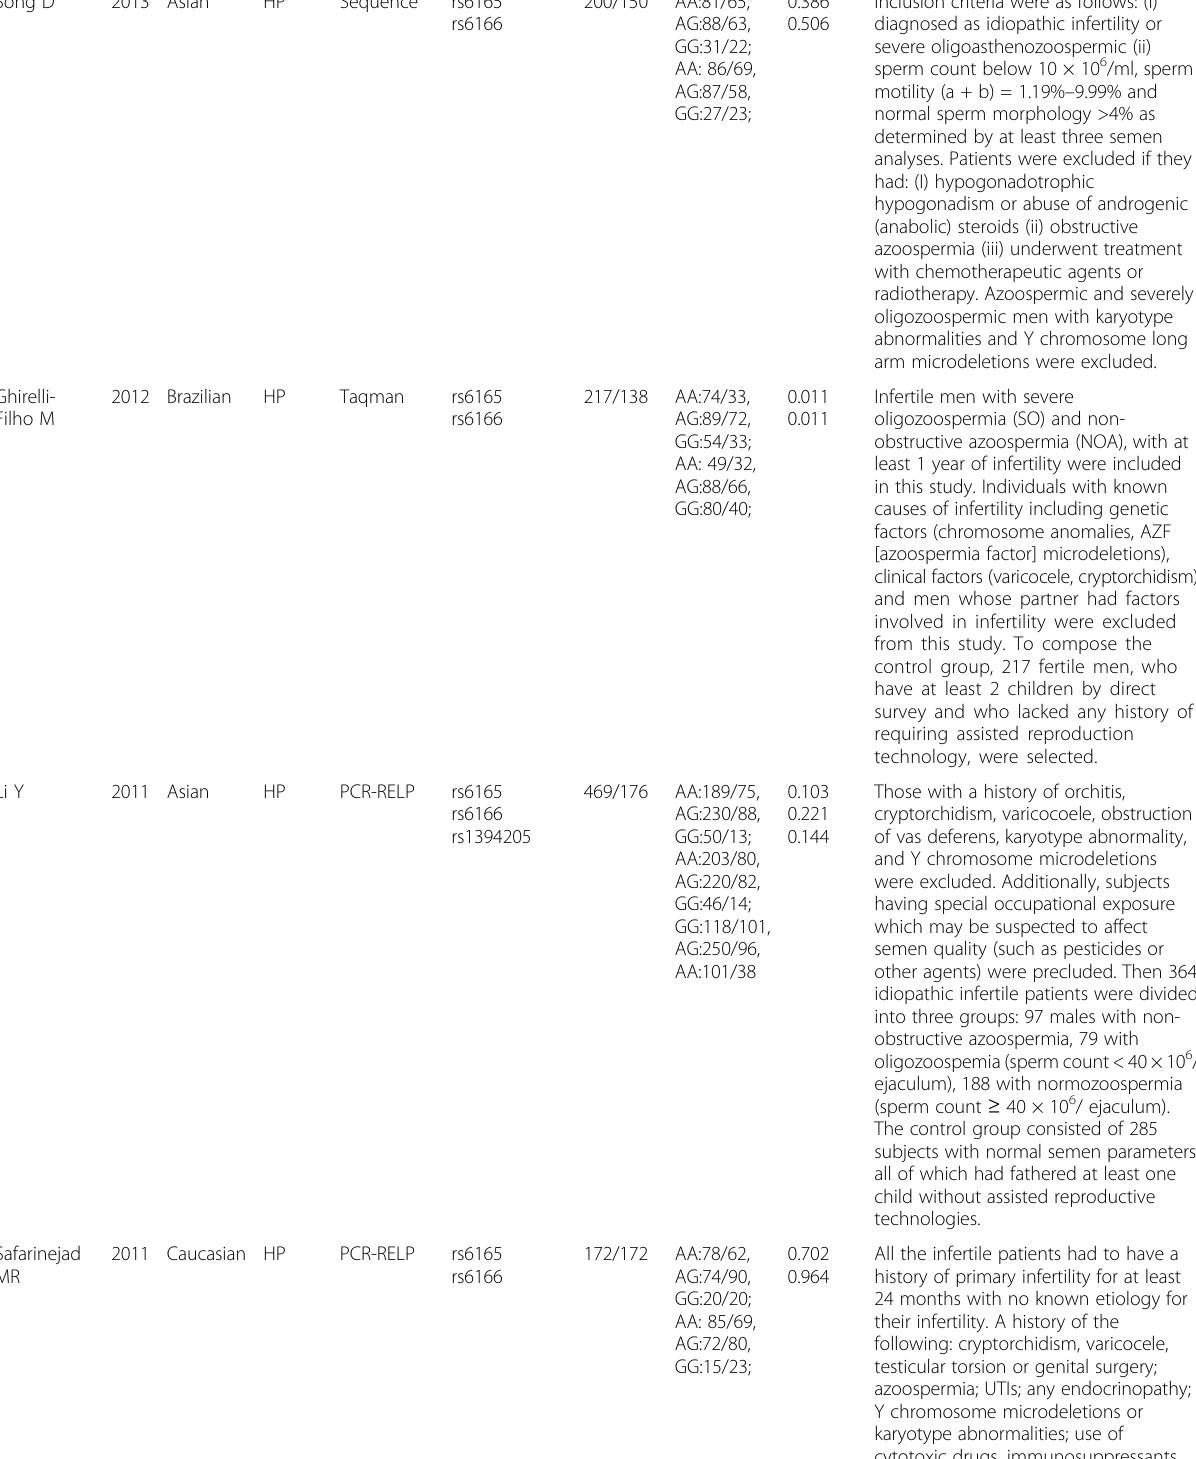
Table 4 Main characteristics of all studies on the genotype of FSHR rs6165, rs6166 and rs1394205 included in the meta-analysis (Continued) Song